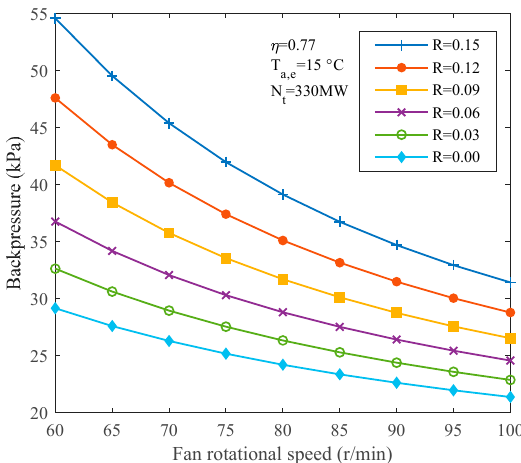
Figure 7. Backpressure at different fan speeds and plume recirculation rates.